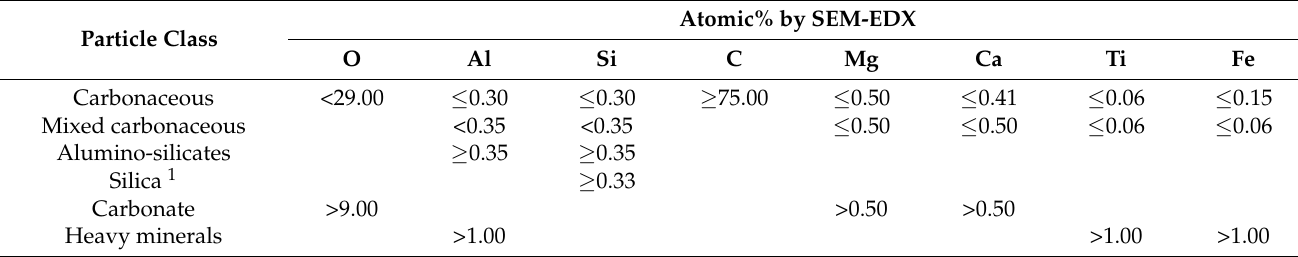
Table 3. SEM-EDX particle classification